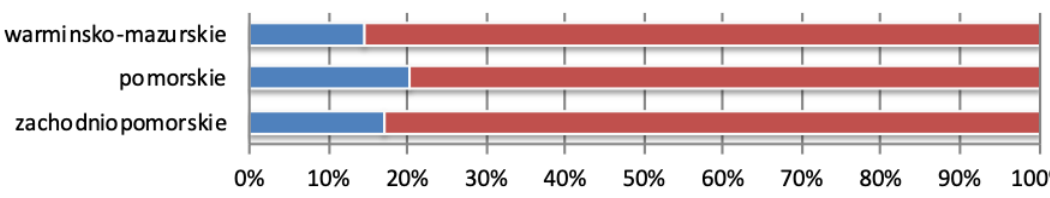
Figure 7. Local land use plans in the provinces. Source: own study based on [55]